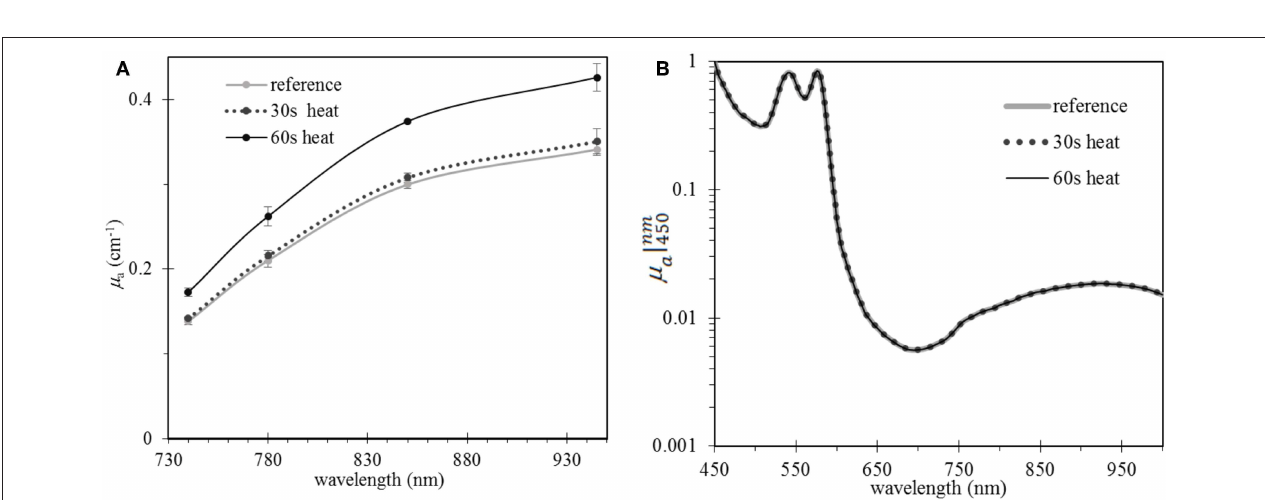
FIGURE 3 | Oxygen saturation affects hemoglobin absorption spectrum: (A) Normalized µ a spectra with respect to µ a at 450nm and (B) oxygen saturation (StO2) over time in four control phantoms: hemoglobin without yeast (Ctr.HbY0), with yeast 5% (Ctr.HbY5), 10% (Ctr.HbY10), and 15% (Ctr.HbY15). Hemoglobin concentration in all phantoms was kept constant at 7 mg/ml.